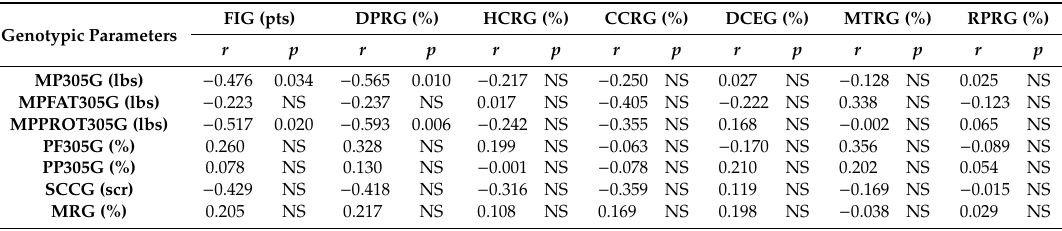
Table 1. Pearson’s Correlation Coe ffi cients between genomic parameters of production and reproductive traits obtained from primiparous high-producing dairy cows for the LI group.